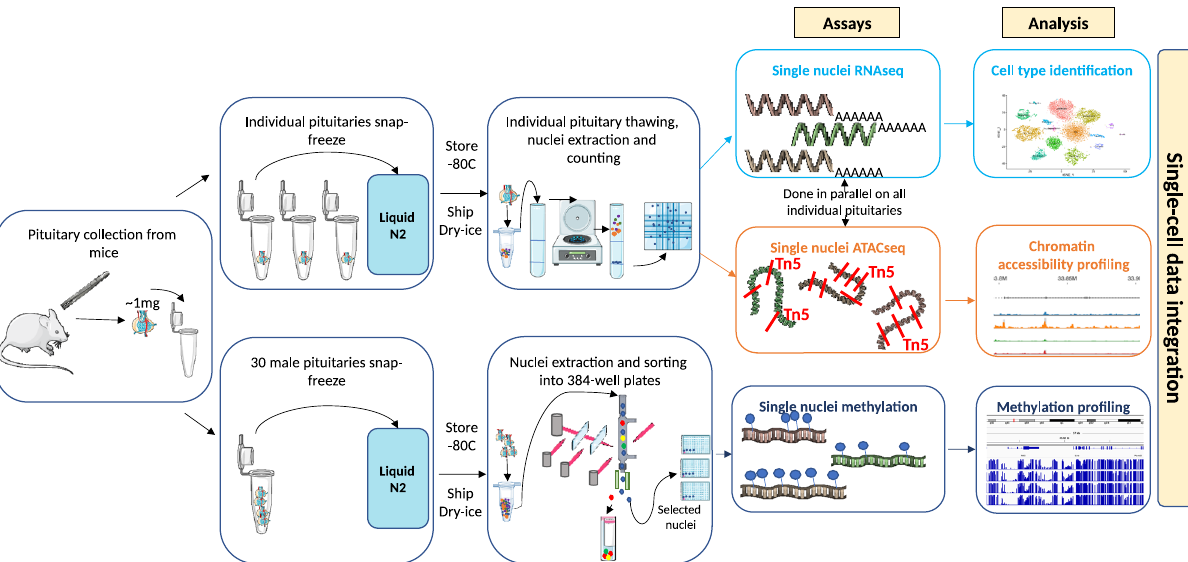
Fig. 1 Overview of pituitary sn multi-omics experimental design. SnRNAseq and snATACseq assays were performed in parallel on each individual snap- frozen murine pituitary following nuclei isolation from individual animals (top row). For snMethyl assays, pituitaries were pooled from 30 male mice, nuclei were isolated and sorted (bottom row). Data analysis was performed on each individual sample, as well as on merged same-sex samples to identify cell types before integrating all assay modalities and animals. Additional studies were performed on cryopreserved dissociated murine pituitary cells, including scRNAseq, snRNAseq, and snATACseq (see Supplementary Fig. 1 and Supplementary Table 1). Figure 1 was created using graphics from Servier